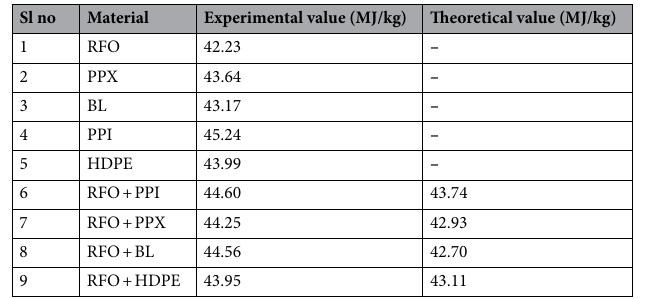
Table 6. Heating value of liquid obtained from the co-cracking of RFO with various types of plastics waste in the presence of ZSM-5 catalyst.